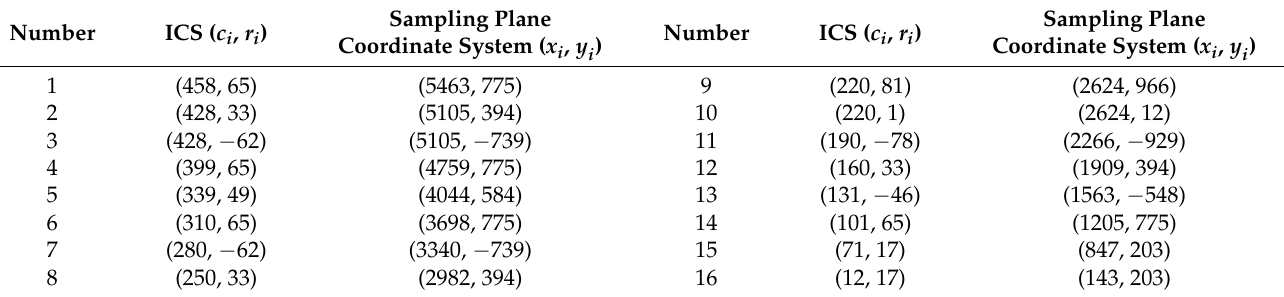
Table 6. ICS (in pixels) conversion to SPCS (in